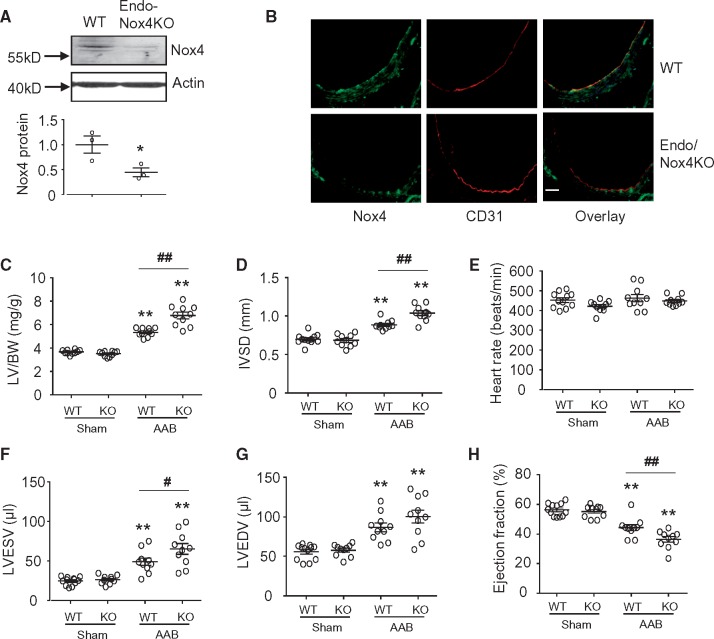
Endo-Nox4KO exhibit worse load-induced dysfunction than wild-type controls. (A) Nox4 protein expression in aorta of wild-type and endo-Nox4KO mice. *P < 0.05, n = 3, unpaired Student’s t-test. (B) Immunostaining for Nox4. Aortic sections stained for Nox4 (green) and CD31 (red) as an endothelial cell marker. Scale bars 50 μm. The yellow colour in the merged images in the right panels denotes co-localization. (C) Mean data for cardiac hypertrophy in terms of left ventricle weight/body weight ratio (LV/BW) (n = 10/group). (D–H) Echocardiographic analysis of WT and Endo-Nox4KO mice subjected to 6 weeks AAB (n = 10–12/group). IVSD, interventricular septal diameter; LVEDV, LVESV, LV end-diastolic and end-systolic volumes; EF, ejection fraction. **P < 0.01 vs. respective sham controls. #P < 0.05, ##P < 0.01 vs. WT/AAB, two-way ANOVA with Tukey’s Multiple Comparison Test. All data are presented as mean ± SEM.